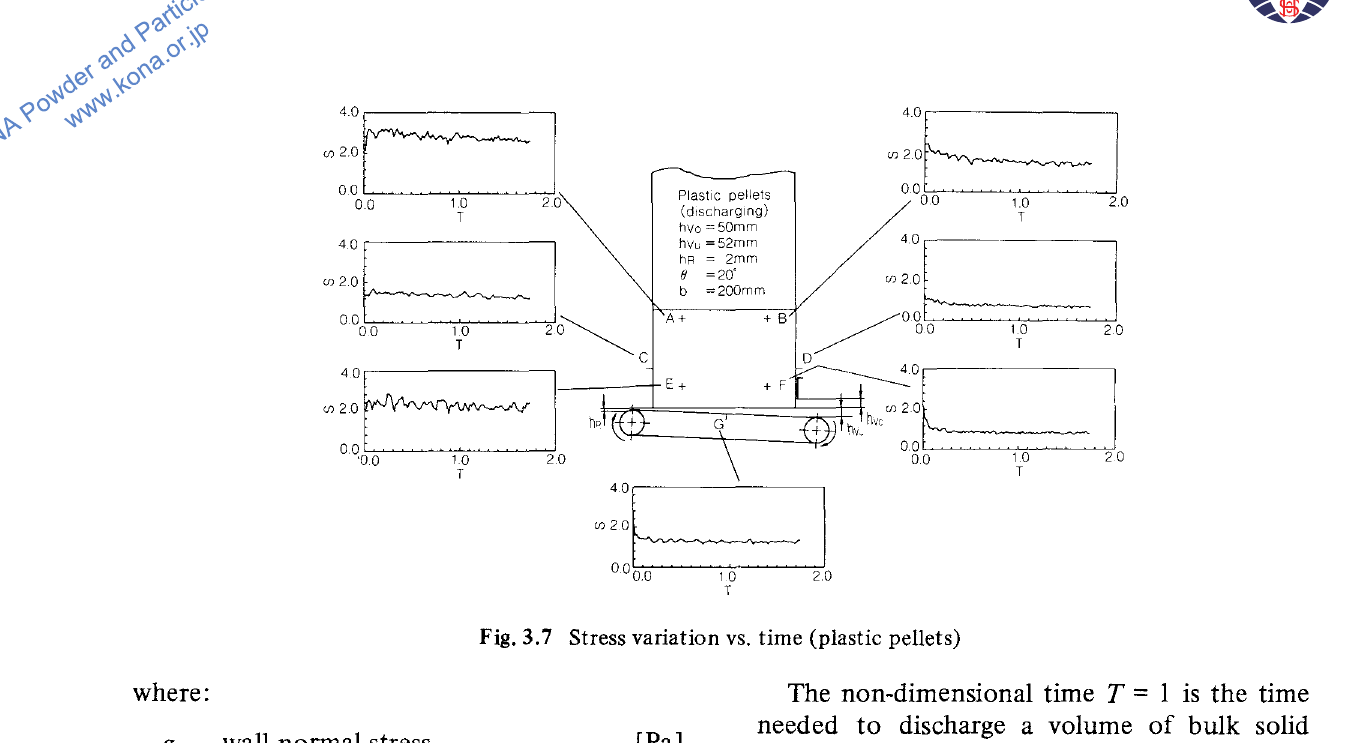
Fig. 3. 7 Stress variation vs. time (plastic pellets)